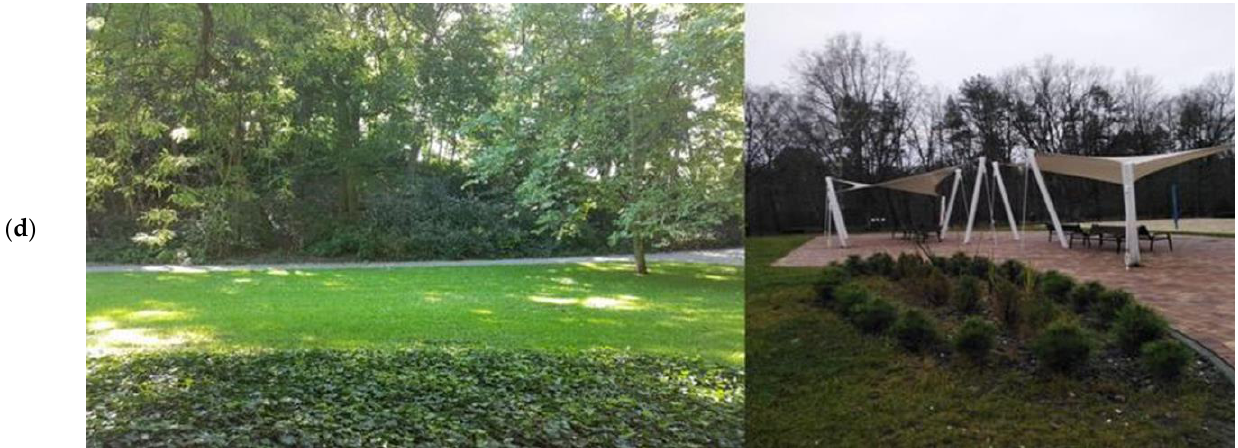
Figure 2. Four types of Warsaw municipal forests (WMF): ( a ) natural forest, no landscaping, similar to a strict nature reserve; ( b ) forest with designated footpaths, picking mushrooms and berries allowed; ( c ) forest with extensive tourism infrastructure, leisure meadows, designated barbecue areas, educational routes with information boards; ( d ) park-like forest, with numerous benches and other small architecture.